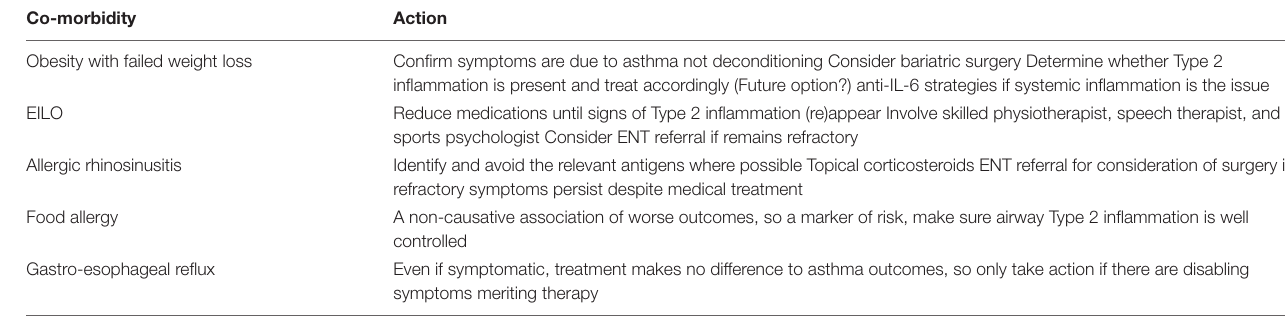
TABLE 5 | Choosing the right medications for school age refractory asthma plus comorbidities (when appropriate).